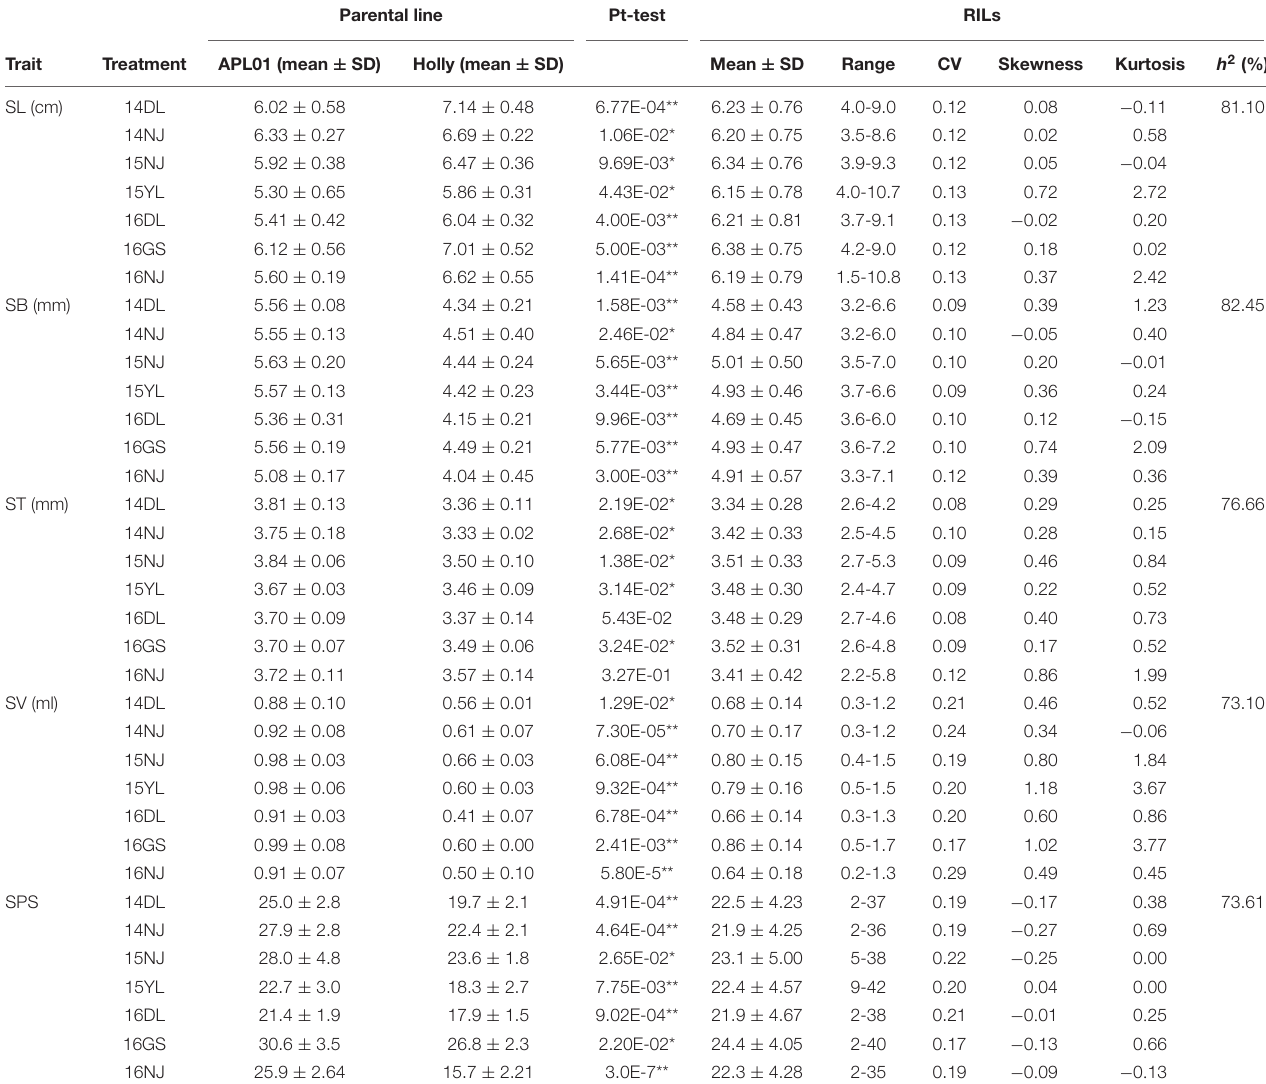
TABLE 1 | Statistical analysis of five silique-related traits for two parents and AH populations in 7 environments. Parental line Pt-test RILs Trait